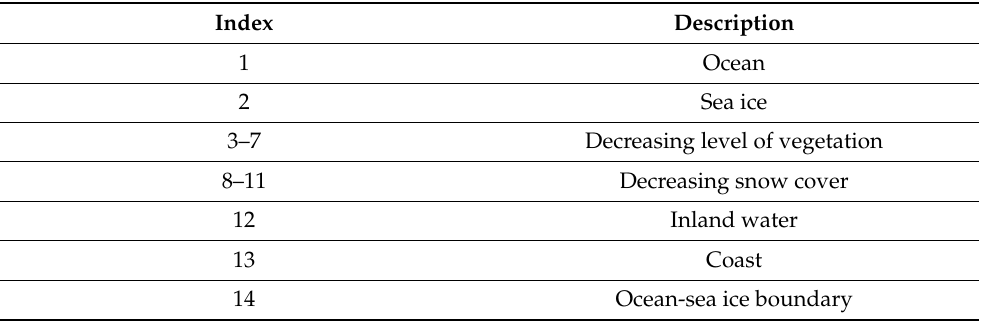
Table A3. Values of the surface type index and the associated surface characteristics, used in the GPM radiometer-only precipitation algorithm GPROF.